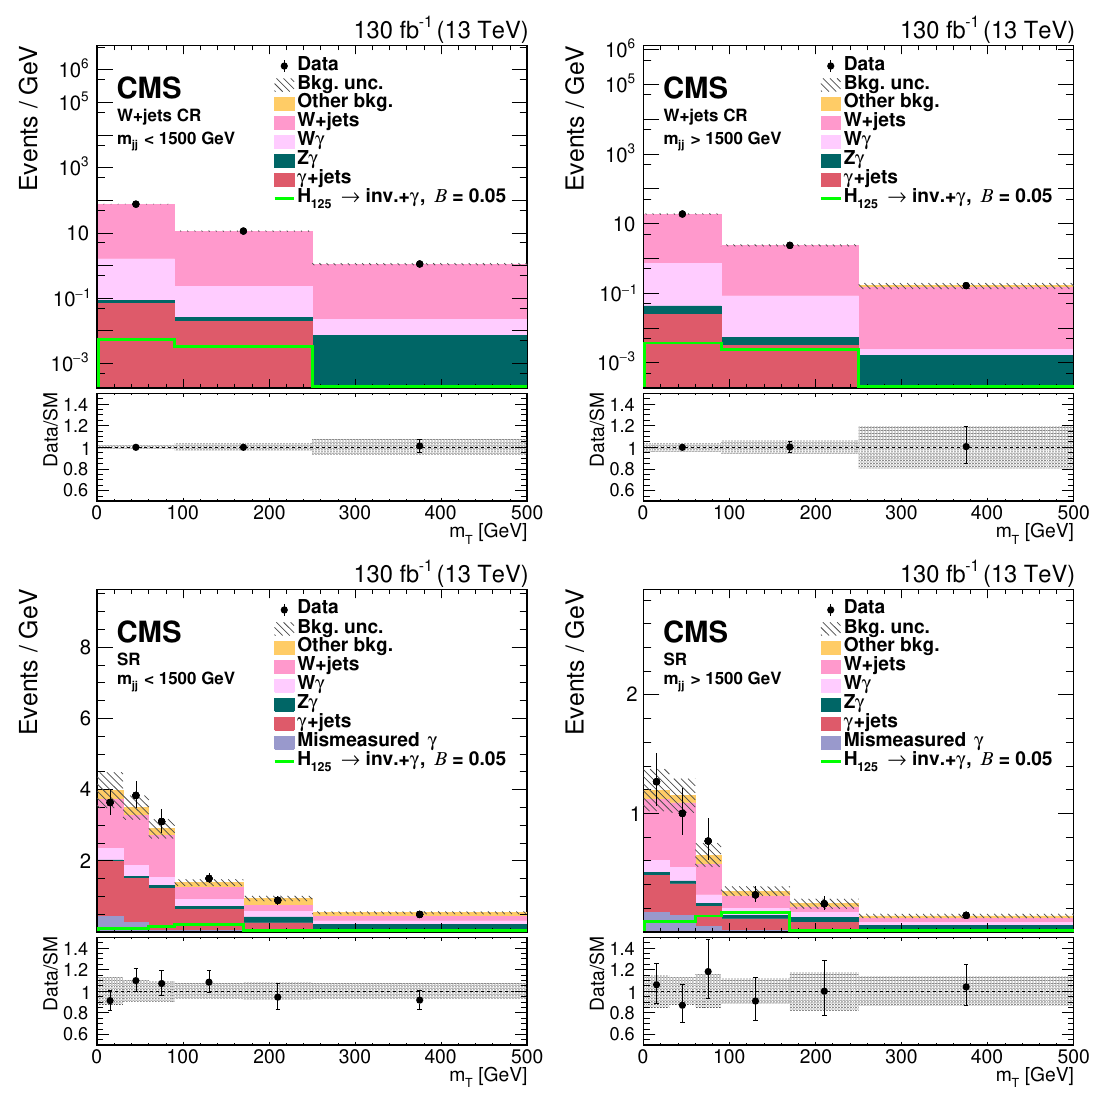
Figure 3 . The m distributions from the simultaneous fit for events with m < 1500 GeV in the T jj W(e n ) + jets CRs (upper left), for events with m ≥ 1500 GeV in the W(e n ) + jets CRs (upper jj right), for events with m < 1500 GeV in the SRs (lower left), and for events with m ≥ 1500 GeV jj jj in the SRs (lower right). The category other background includes contributions from Z + jets, nonprompt, top quark, VV , and VVV processes. Overflow events are included in the last bin. The shaded bands represent the combination of the statistical and systematic uncertainties in the predicted yields. The light green line, illustrating the possible contribution expected from inclusive SM Higgs boson production, assumes a branching fraction of 5% for H → inv. + γ decays. The lower panel in the figures shows a per-bin ratio of the data yield and the background expectation. The shaded band corresponds to the combined systematic and statistical uncertainty in the background